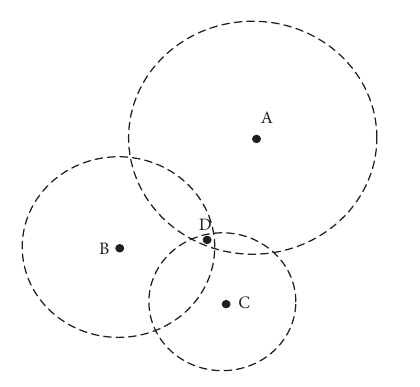
Figure 13: Principle of trilateral positioning method.